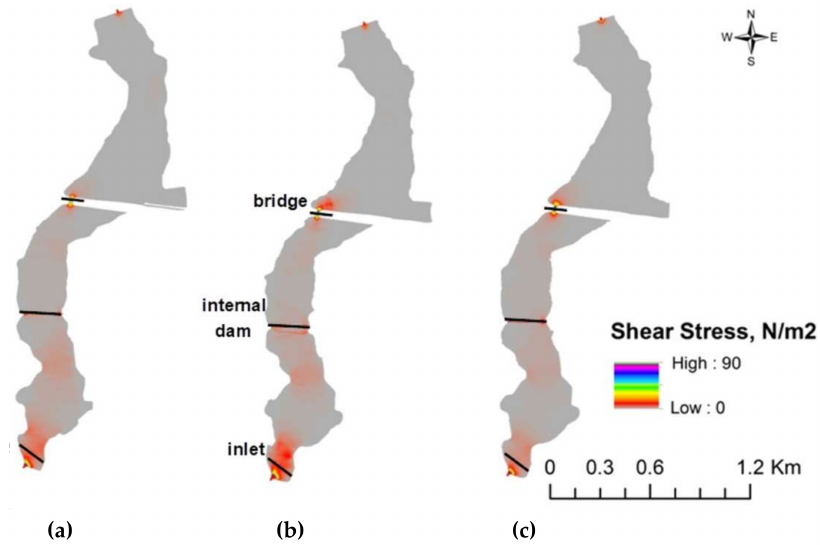
Figure 12. Shear stress calculated for the Stare Miasto reservoir and three bathymetries: ( a ) Bathymetry 2006; ( b ) bathymetry 2013; ( c ) bathymetry